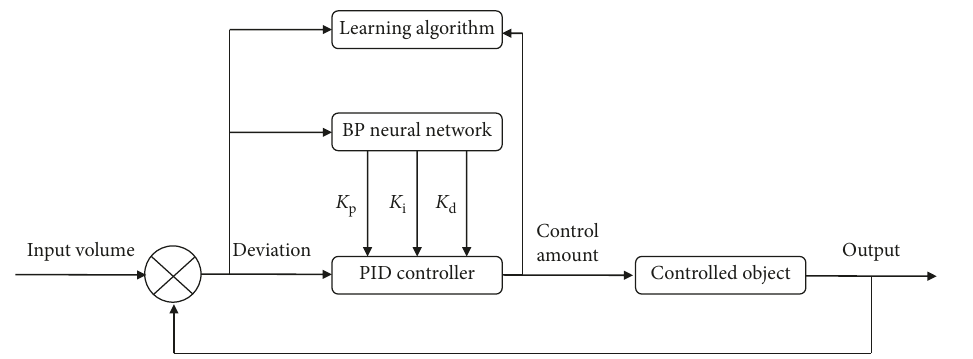
Figure 3: Structure of the BP neural network PID